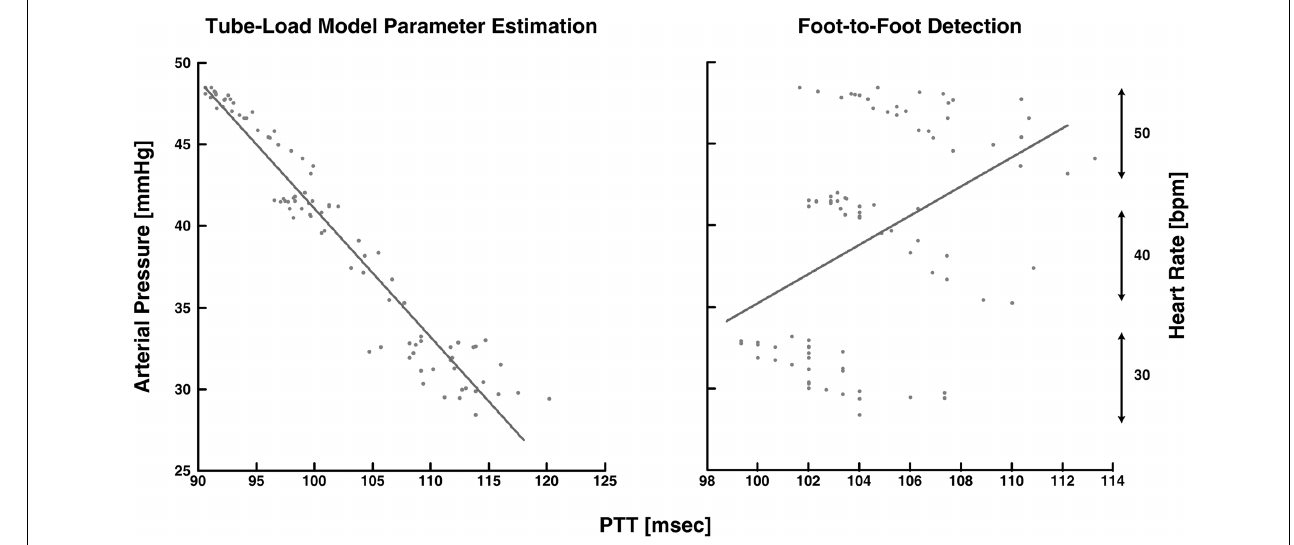
FIGURE 8 | Measured arterial pressure versus pulse transit time (PTT) estimated from central aortic and femoral arterial pressure waveforms. Adapted from Zhang et al. (2011).